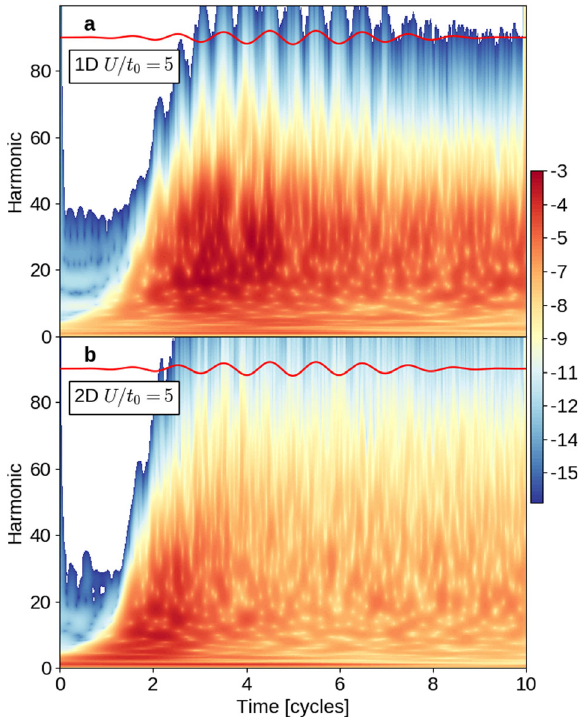
Fig. 4 Time-resolved high-harmonic emission. Spectrograms showing the log of the emission in 1D ( a ) and 2D ( b ), at U / t 0 = 5. The scales are chosen to highlight the high-frequency, low-intensity emission required to observe sub-cycle characteristics not seen in the emission ranges of Fig.